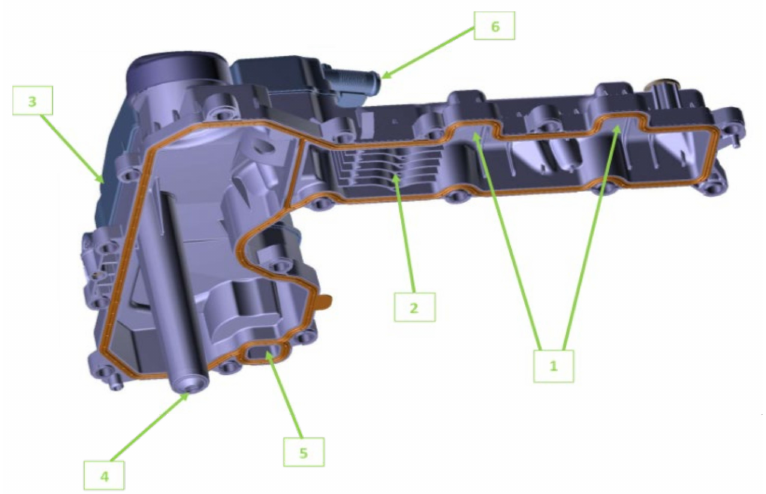
Figure 4. Oil separator of EB2dts engine.